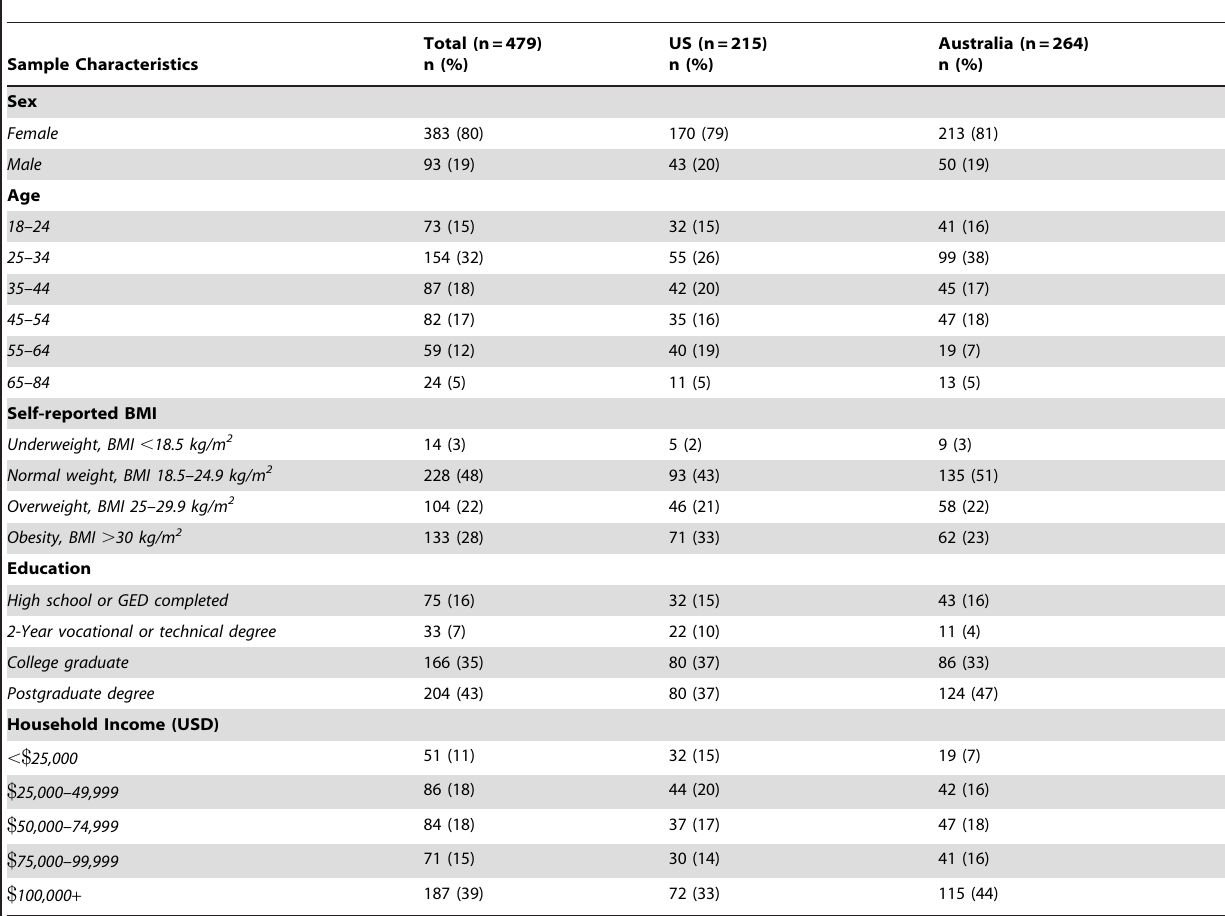
Table 1. Demographic characteristics of